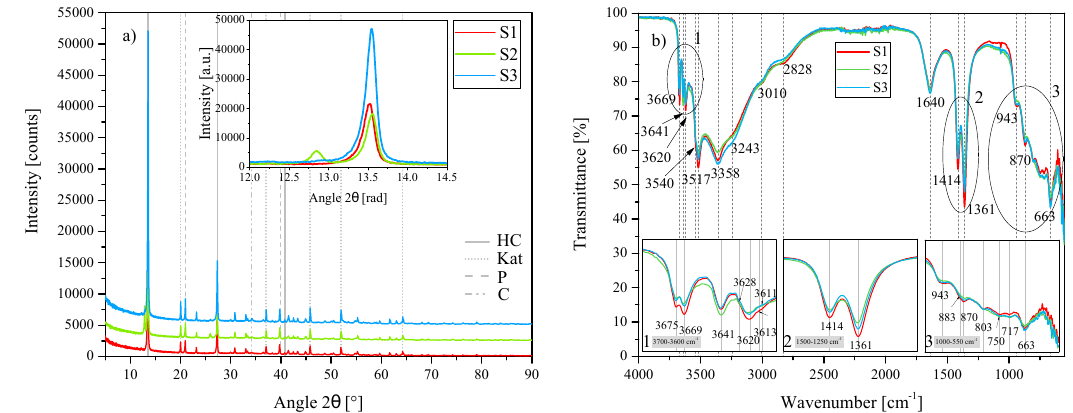
Figure 1. ( a ) XRD results of the three standard hydrocalumite (HC) layered double hydroxides (LDHs) S1, S2 and S3 between 5 ◦ 2 θ and 90 ◦ 2 θ . Each scan is y-shifted by 2500 counts. The inset depicts the primary LDH peaks and change in position. HC = hydrocalumite, Kat = katoite, P = portlandite and C = calcite. ( b ) FTIR-ATR scans of the three standard HC LDHs S1, S2 and S3 between 4000cm − 1 and 550cm − 1 . The three insets show the regions: ( 1 ) 3700cm − 1 –3600cm − 1 , ( 2 ) 1500cm − 1 –1250cm − 1 , ( 3 ) 1000cm − 1 –550cm − 1 in detail. Dashed and solid grey lines indicate the maxima of